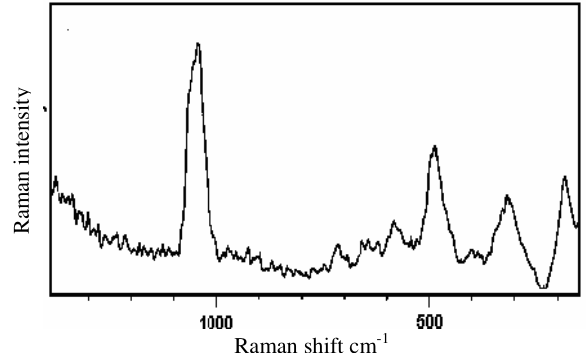
Figure 2. Raman spectrum of gallosilicate nitrate cancrinite